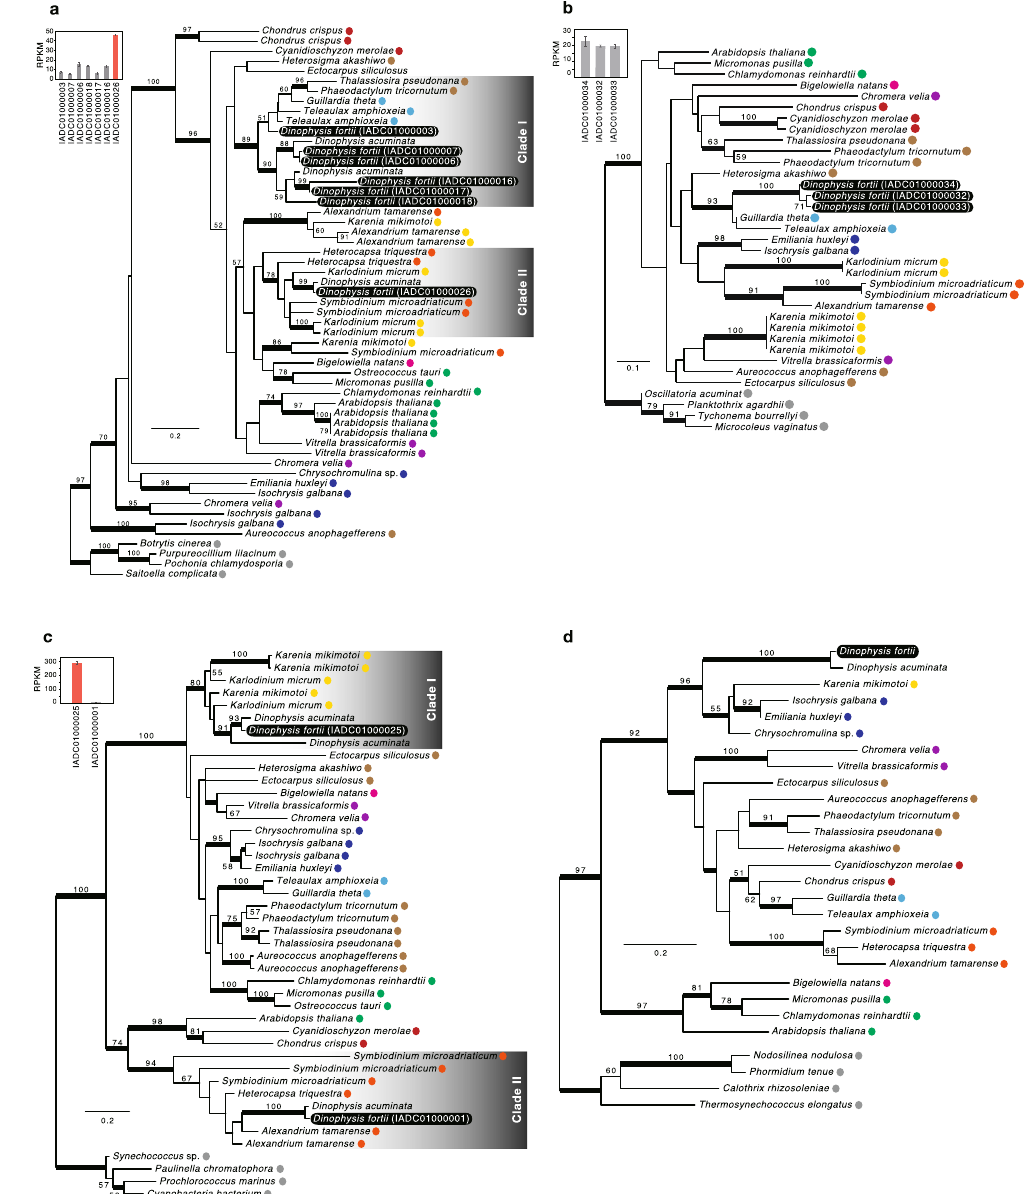
Figure 3. Maximum-likelihood trees of ( a ) ascorbate peroxidase, ( b ) PetC, ( c ) PetH and ( d ) PsbO. Bootstrap values ≥ 50% are shown. Nodes supported by Bayesian posterior probabilities ≥ 0.95 are highlighted with bold lines. Where two or more isoforms were identified, transcription levels are shown in the inset bar chart in the top left corner, and the isoform with the highest transcription level is highlighted with a red bar in the bar chart. Transcriptome shotgun assembly (TSA) accession numbers are provided in parentheses. Coloured circles indicate proteins from the same organisms as described in Fig.